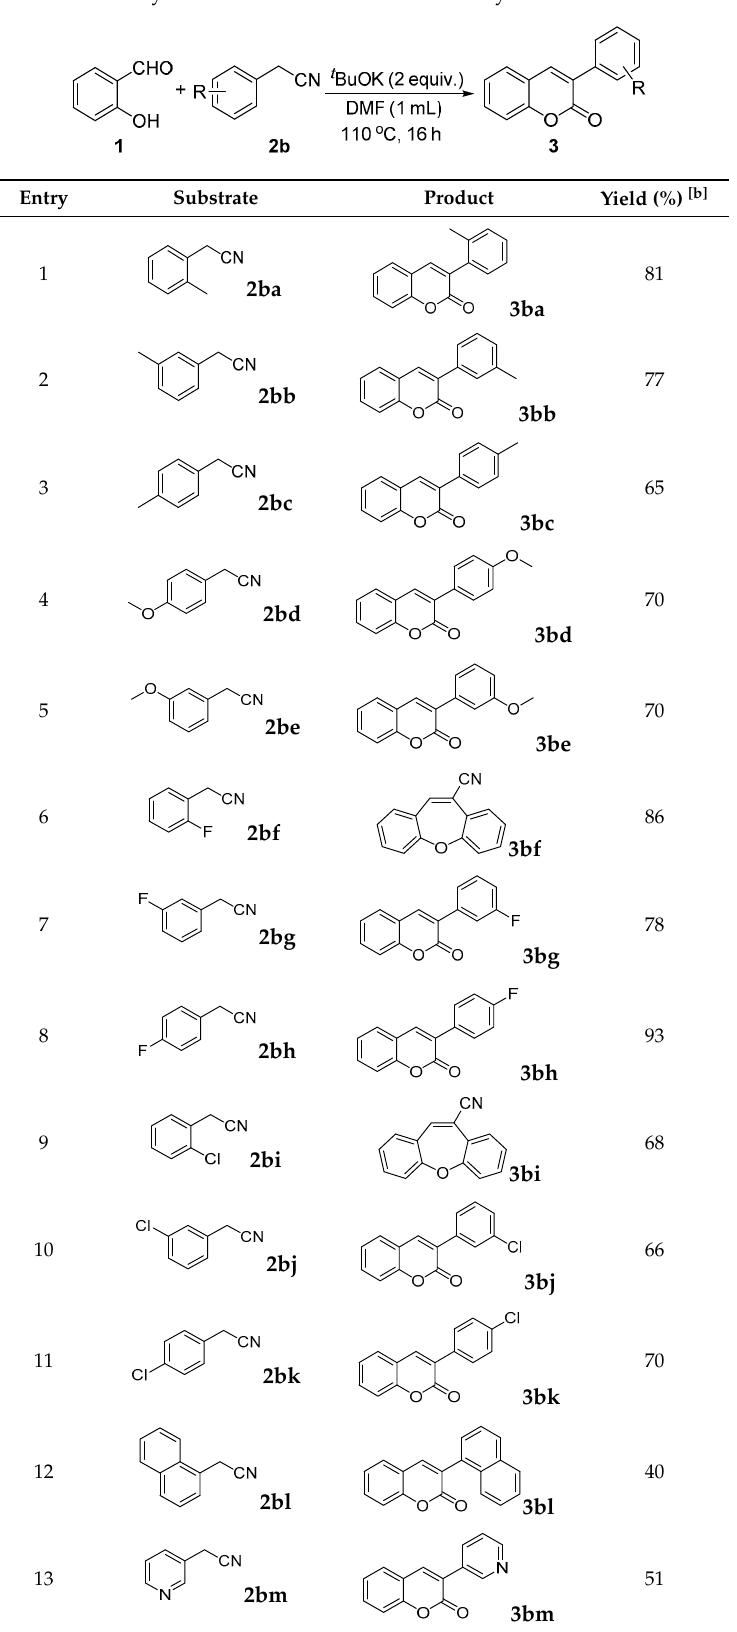
Table 3. Synthesis of chromenones from 2-arylacetonitriles [a] .